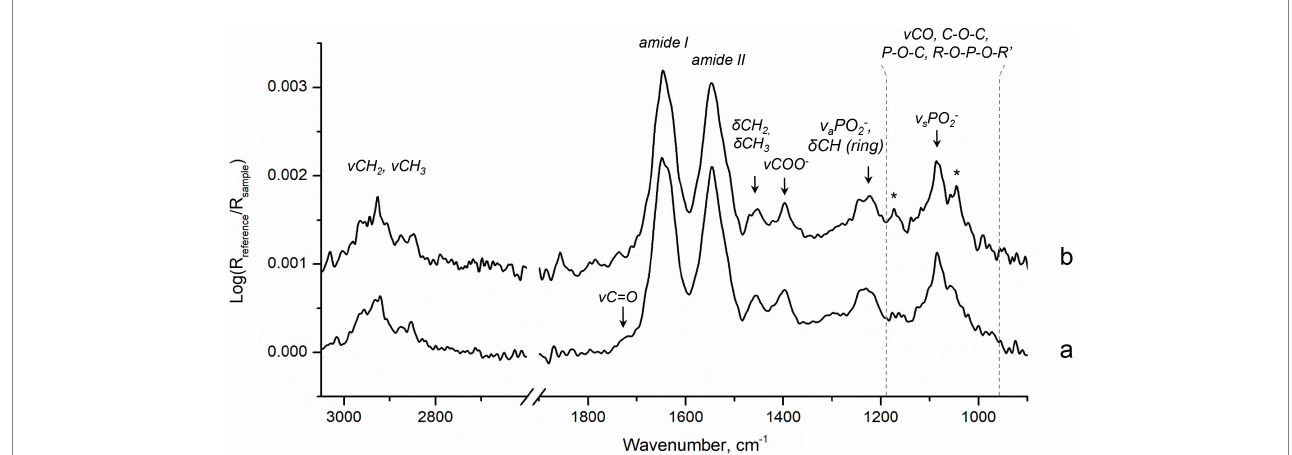
FIGURE 5 ATR-FTIR spectra of biofilms in (a) the beginning, 20 min, and (b) the end, 6 h, of Hg methylation assay. Stars indicate slight contribution of bands corresponding to MOPS buffer (Supplementary Figure S2) in spectra of